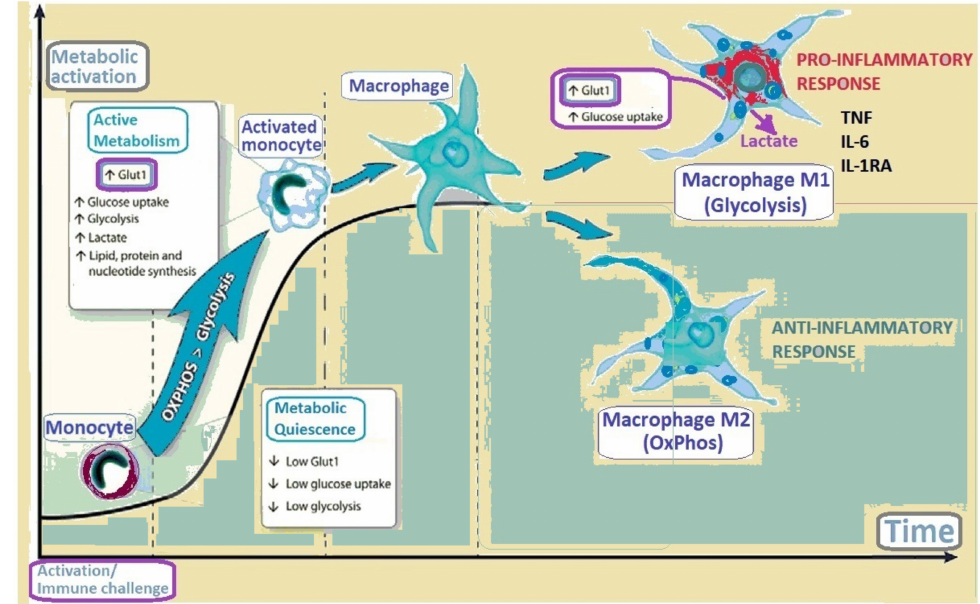
Figure 4. Immune challenge induces metabolic activation with increased GLUT1 expression, glucose uptake and glycolysis. The transition of monocytes to macrophages is characterized by further increases in Glut1 expression and glycolysis. Naive (unactivated) monocytes are metabolically quiescent, with low basal metabolic activity and ATP derived primarily via oxidative phosphory- lation (OxPhos). Classically activated macrophages (M1) induce aerobic glycolysis, resulting in lactate production and the increased production of inflammatory cytokines. Alternatively activated macrophages (M2) trigger a metabolic profile with OxPhos and an anti-inflammatory response. TNF: Tumor necrosis factor; IL-6: Interleukin 6; IL-1RA: interleukin-1 receptor